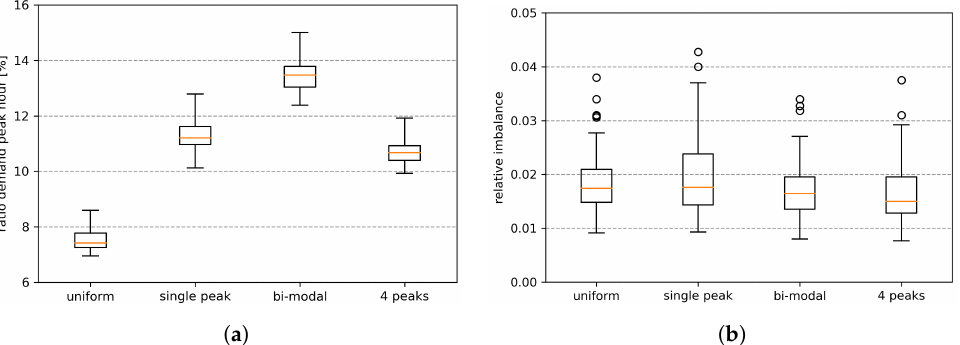
Figure 10. Reconstructing peak-hour demand and maximum stock based on knowledge of the accumulated daily demand and the shape of the demand profile. ( a ) Relation of peak hour demand to daily demand. ( b ) Relation of largest imbalance to daily